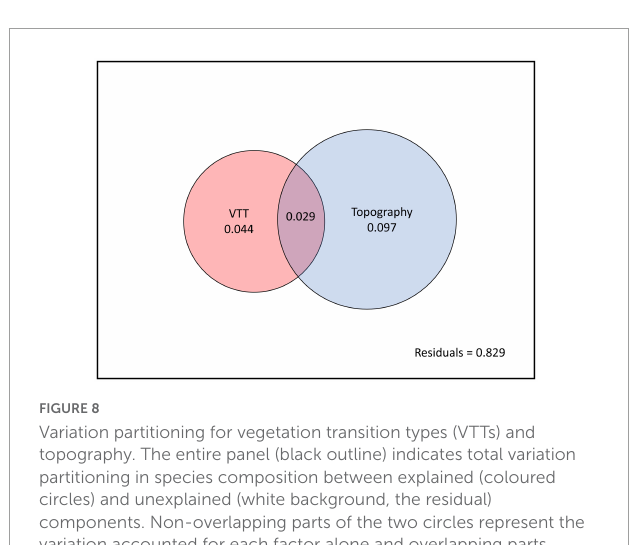
FIGURE8 Variation partitioning for vegetation transition types (VTTs) and topography. The entire panel (black outline) indicates total variation partitioning in species composition between explained (coloured circles) and unexplained (white background, the residual) components. Non-overlapping parts of the two circles represent the variation accounted for each factor alone and overlapping parts represent the variation accounted for by both factors